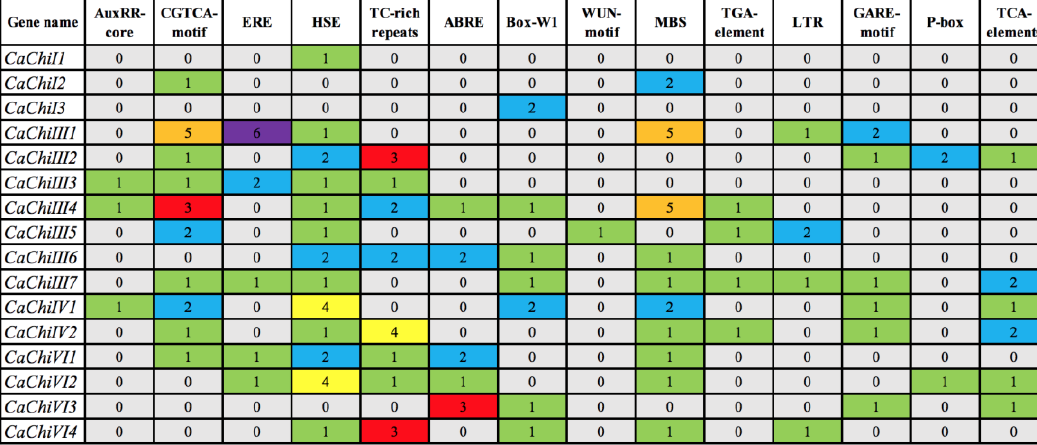
Figure 5. Cis -acting regulatory elements in the promoter regions of CaChi genes. The cis -element positions in the individual CaChi promoter region was inferred from the Plant CARE website (Available online: http://bioinformatics.psb.ugent.be/webtools/plantcare/html/). The different number of cis regulatory elements represent in different colors.